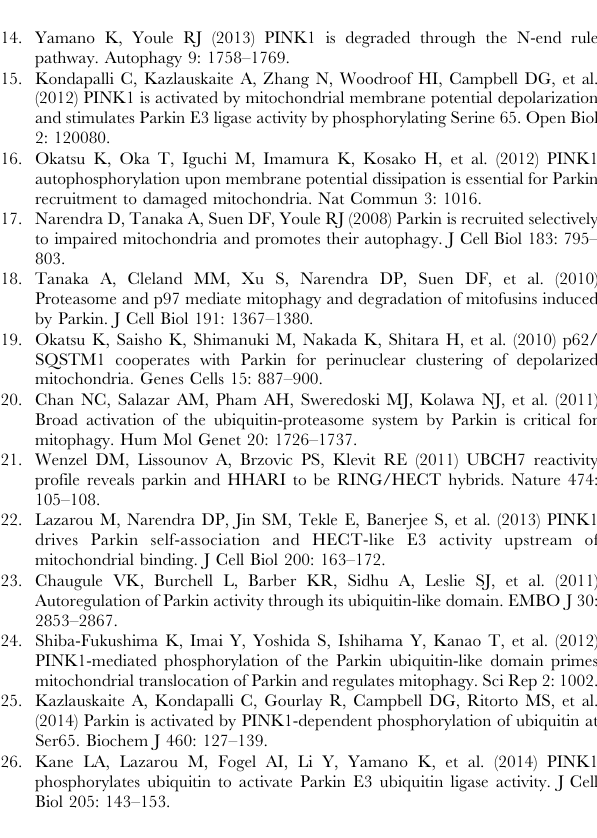
Figure S10 The loss of HOIL-1 does not affect the mitochon- drial translocation of Parkin. ( A ) HOIL-1 + / + and HOIL-1 2 / 2 MEFs retrovirally introduced with GFP-Parkin were treated with 10 m M valinomycin for 4 hr. GFP-Parkin and the mitochondria were visualized with the GFP signal (green) and anti-Tom20 (red), respectively. The Parkin and Tom20 signals are also shown as monochrome images. Scale bar = 20 m m. ( B ) Translocation efficiency of GFP-Parkin in HOIL-1 + / + and HOIL-1 2 / 2 MEFs treated as in ( A ). The graph indicates means 6 SEM of the percentages of cells exhibiting mitochondrial recruitment in